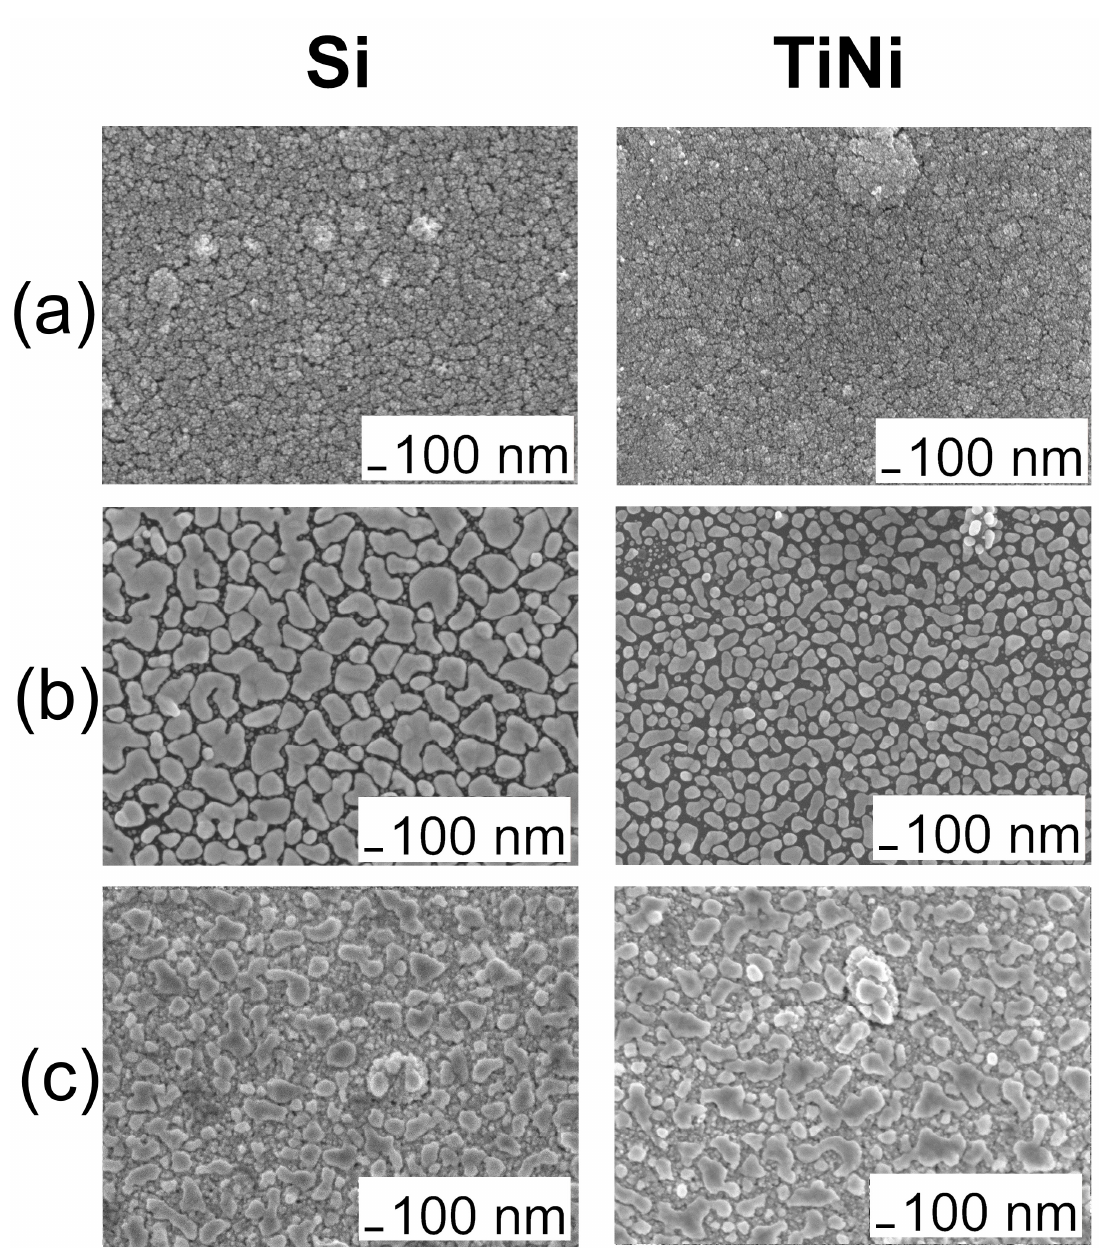
Figure 5. SEM micrographs of the surface of ( a ) Ir, ( b ) Au, and ( c ) Au/Ir samples deposited on Si and TiNi in the same MOCVD experiments ( a —Ir deposition and b , c —Au deposition); magnification 50,000